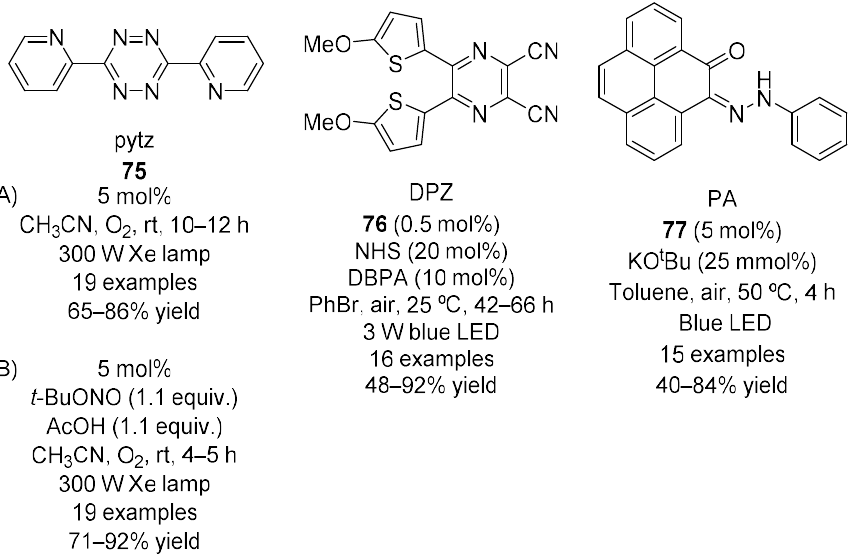
Figure 21. Results obtained in the aerobic photo-oxidation of aromatic and aliphatic alcohols to al- dehydes and ketones 69 catalyzed by 75 – 77 .